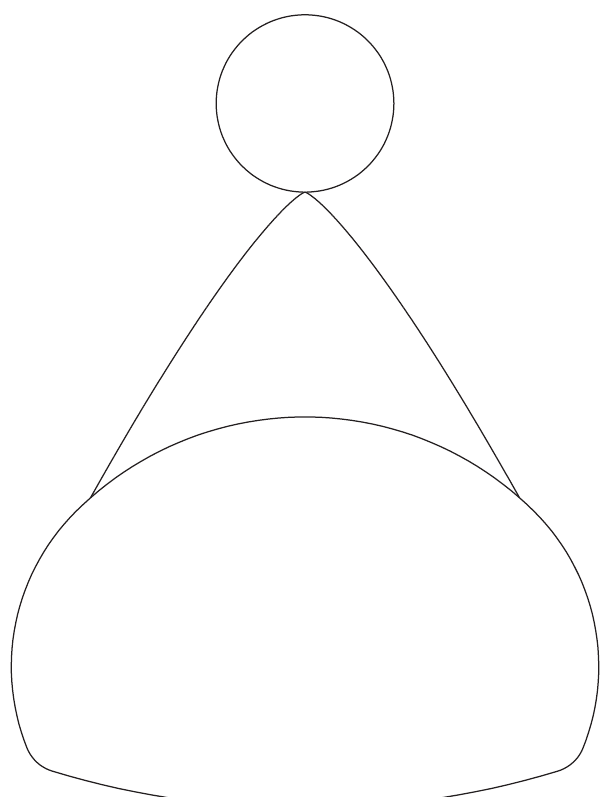
Figure 11: The shape and range of the collapse surface for the Wuzhishan